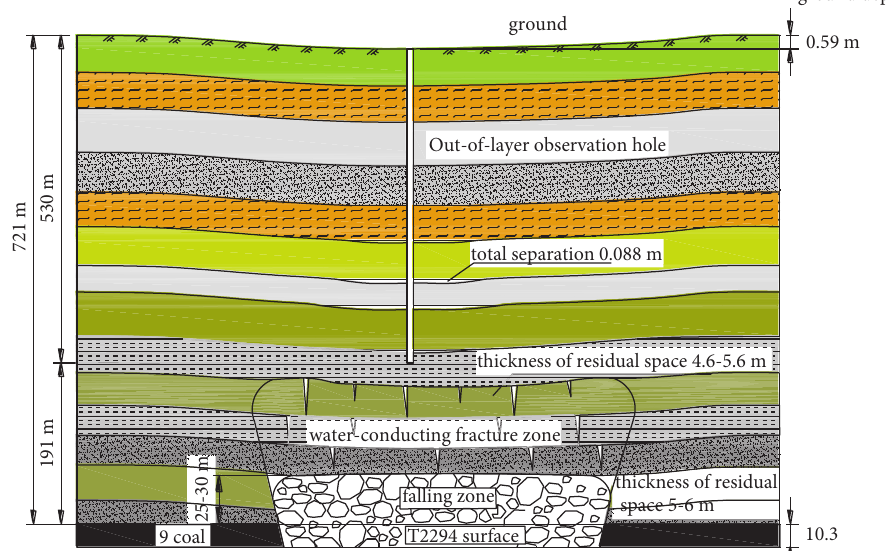
Figure 5: Map of the spatial distribution of overlying rock remaining after mining subsidence stability in the second mining